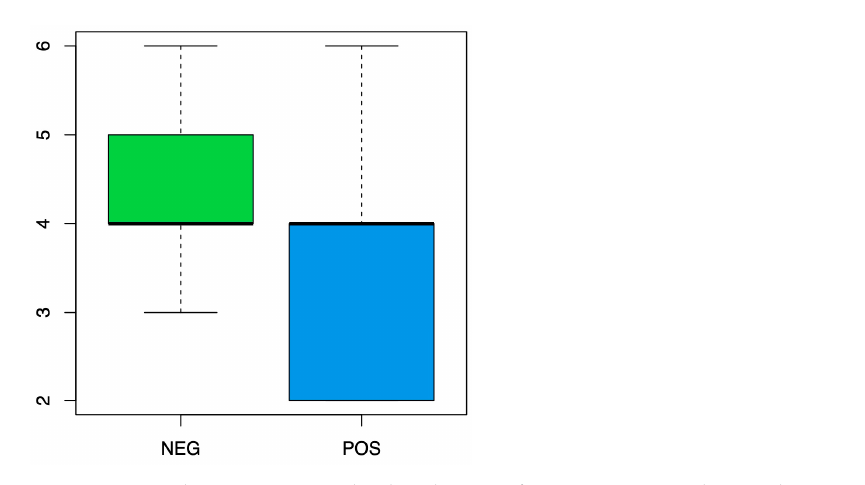
Figure 5. Box plot representing the distribution of IDH status according to the F5 VASARI variable.